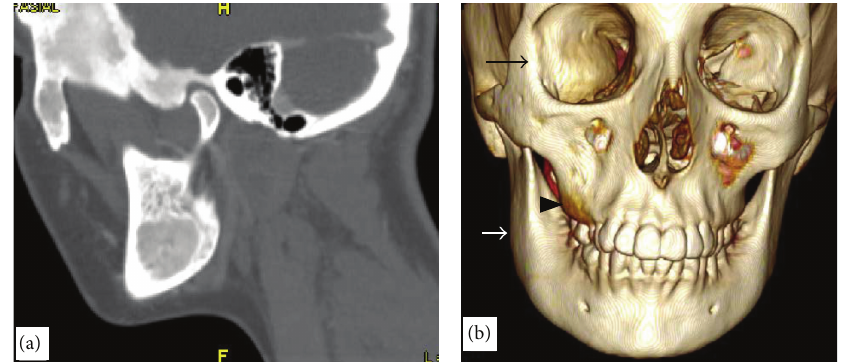
Figure 4: (a) Sagittal reformatted CT images showing expansive mixed lesions involving the mandible, temporal bone, and zygomatic bone. (b) 3D CT images showing the CFD affecting the right side of the mandible (white arrow), in the right maxilla (black arrow head), in the right lateral wall of the orbit (black arrow).